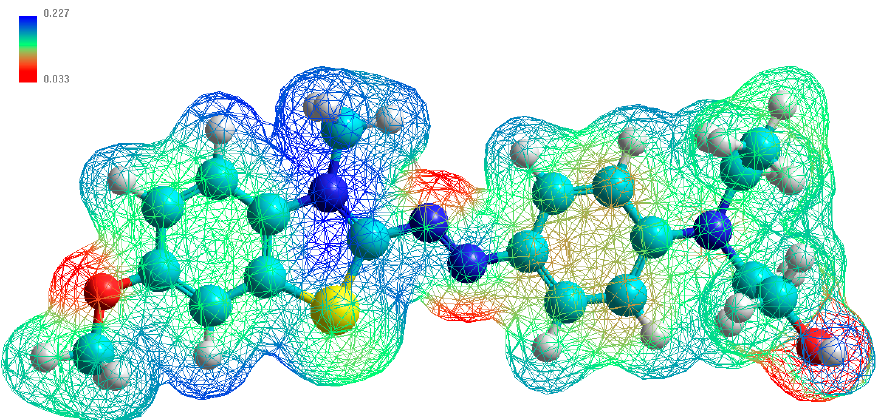
Figure 11. Three-dimensional (3D) mapped isosurface of the electrostatic potential surrounding BB-41 molecule.